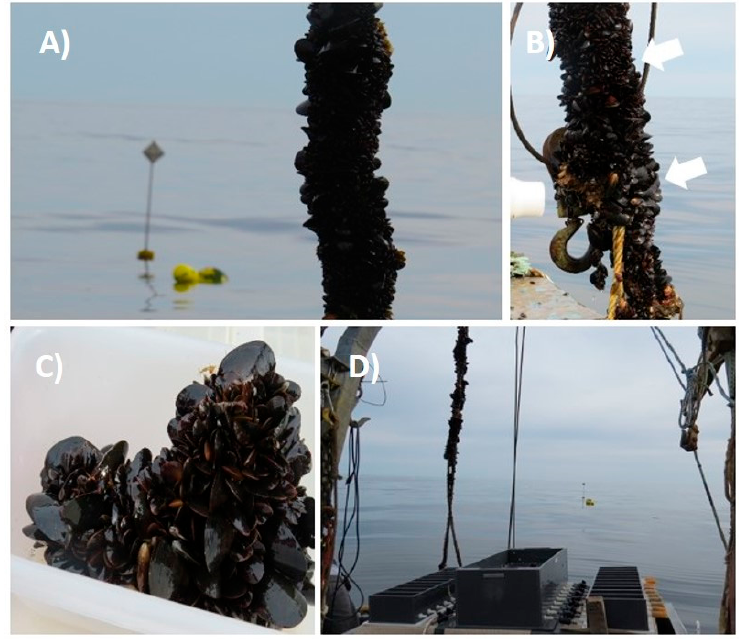
Figure 4. View of NEMAC farm: ( A ) farm demarcation; ( B ) mussel longline (arrows point to different mussel settlements—an indication of natural seeds availability); ( C ) detail of mussels with clean shells; ( D ) biodeposition onboard setup.